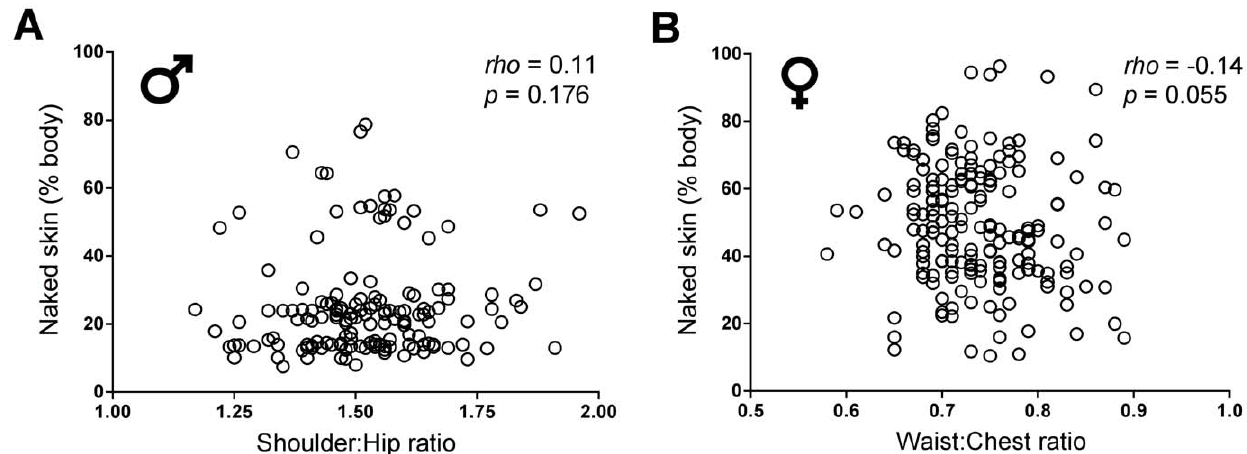
Figure 4. Contribution of sexualized portrayal of body shape to skin disclosure. Shown is the percentage of naked skin disclosed by male (A) and female (B) avatars as a function of body proportions related to sexual attractiveness (frontal shoulder:hip ratio in males, frontal waist:chest ratio in females). Spearman correlation analyses revealed no significant relationship between body proportions and the percentage of exposed naked skin, indicating that virtual skin disclosure is independent of any hypersexualization of avatar body shapes.